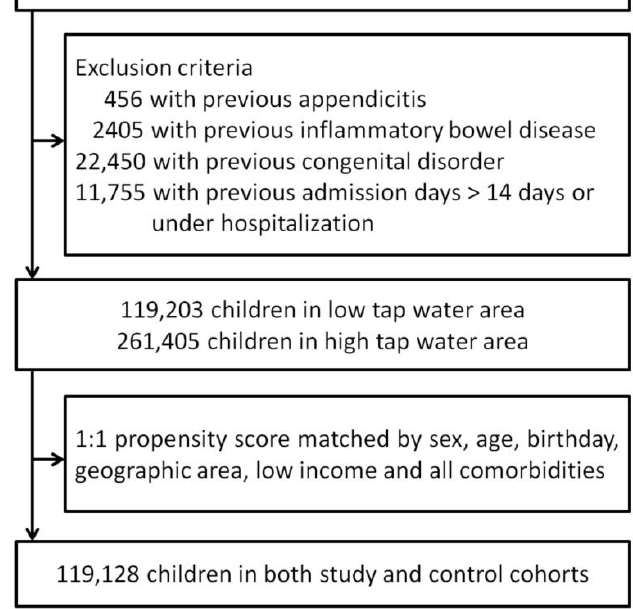
Figure 2. Patient selection diagram.